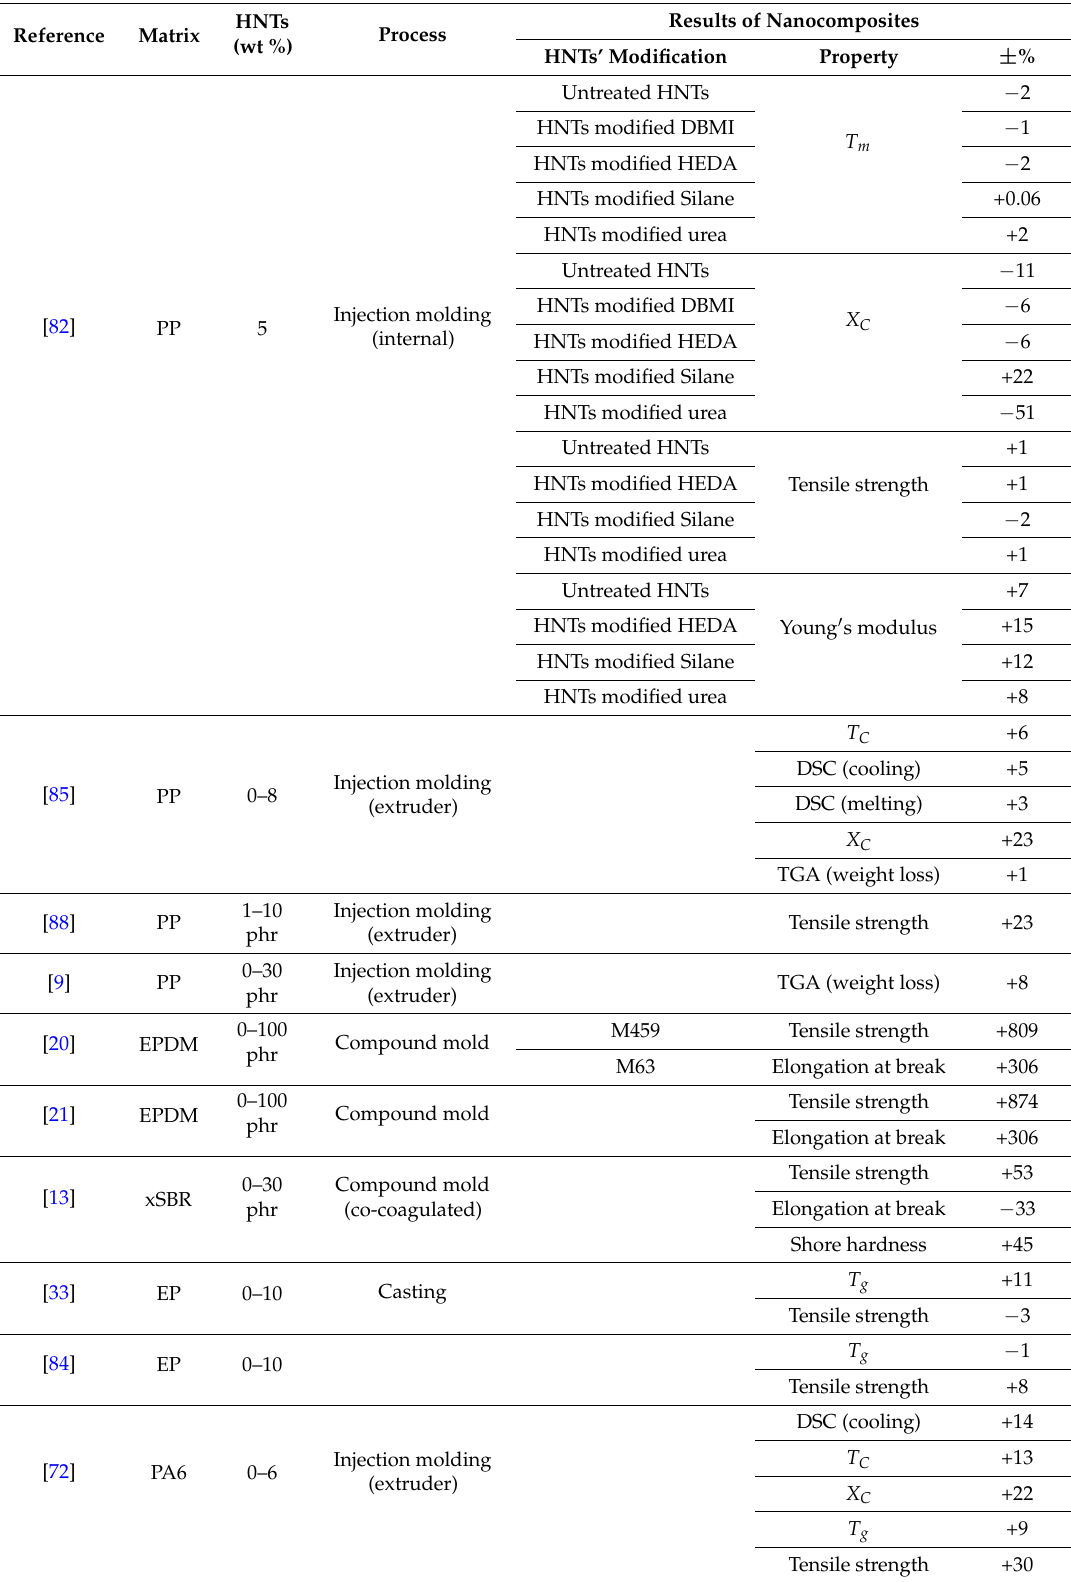
Table 5. Halloysite nanotubes-polymer nanocomposites in